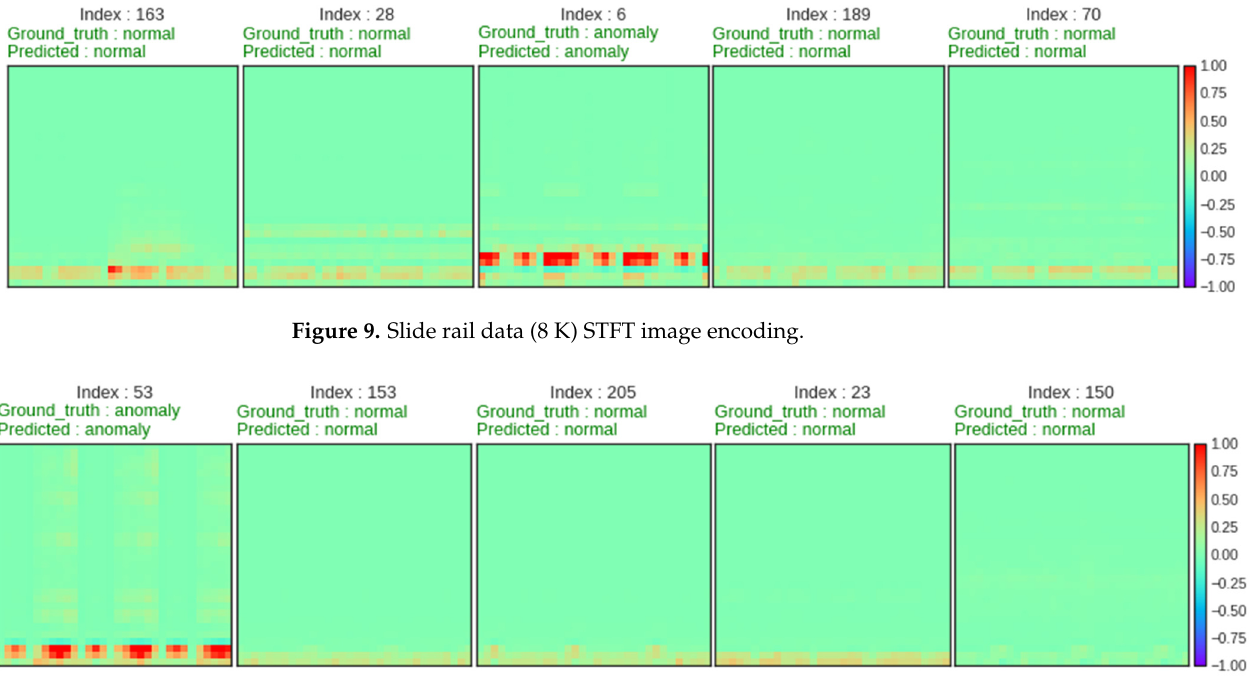
Figure 10. Slide rail data (16 K) STFT image encoding.